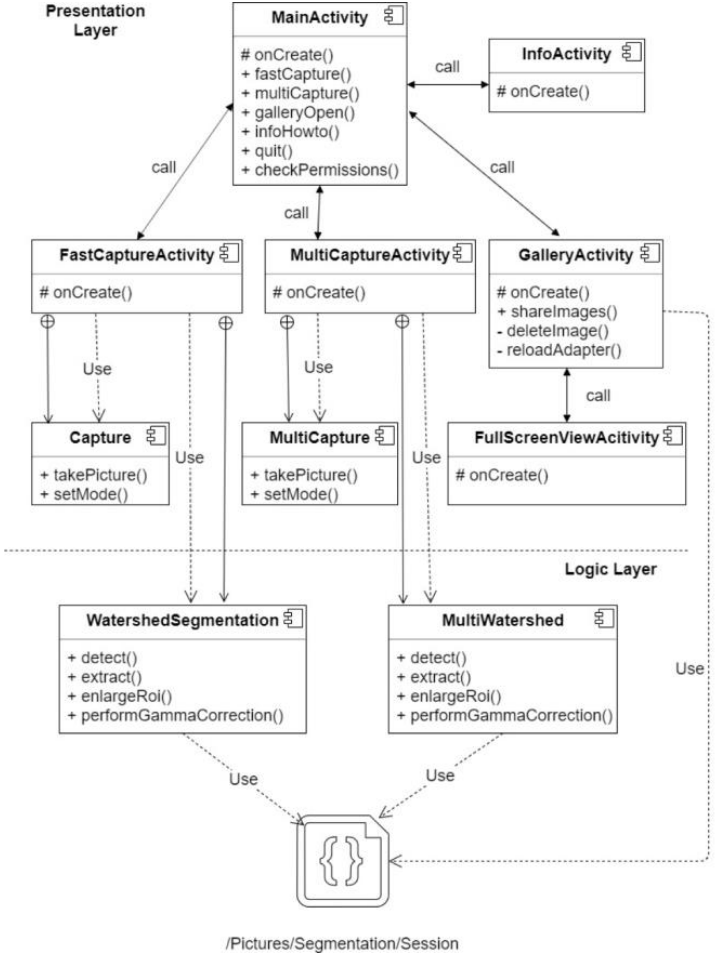
Figure A1. Software architecture.